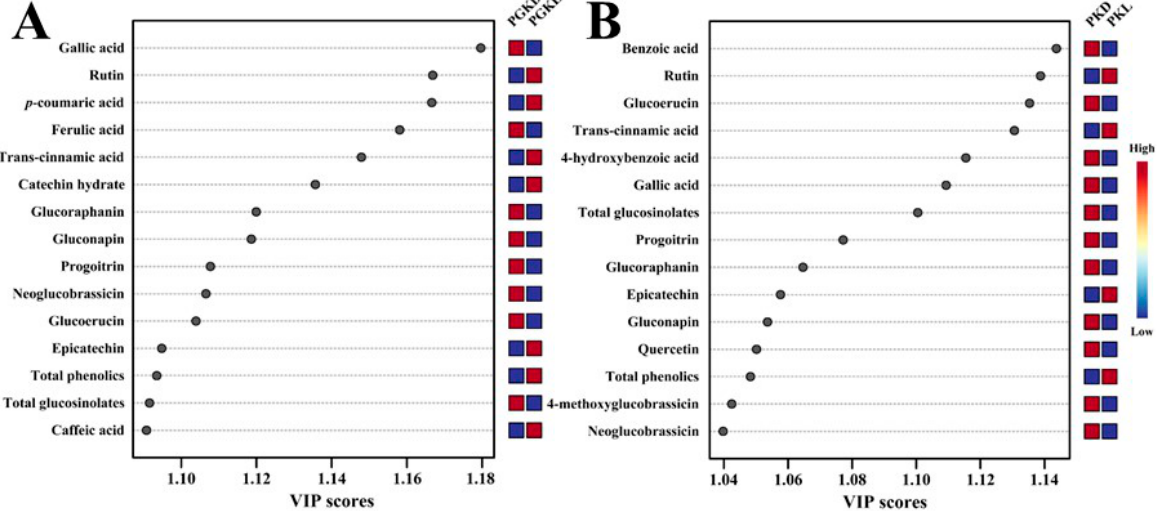
Figure 4. The key compounds separating the PGK ( A ) and PK ( B ) cultivars grown under light and dark conditions based on the variable importance in projection (VIP) in partial least squares discriminant analysis (PLS-DA).